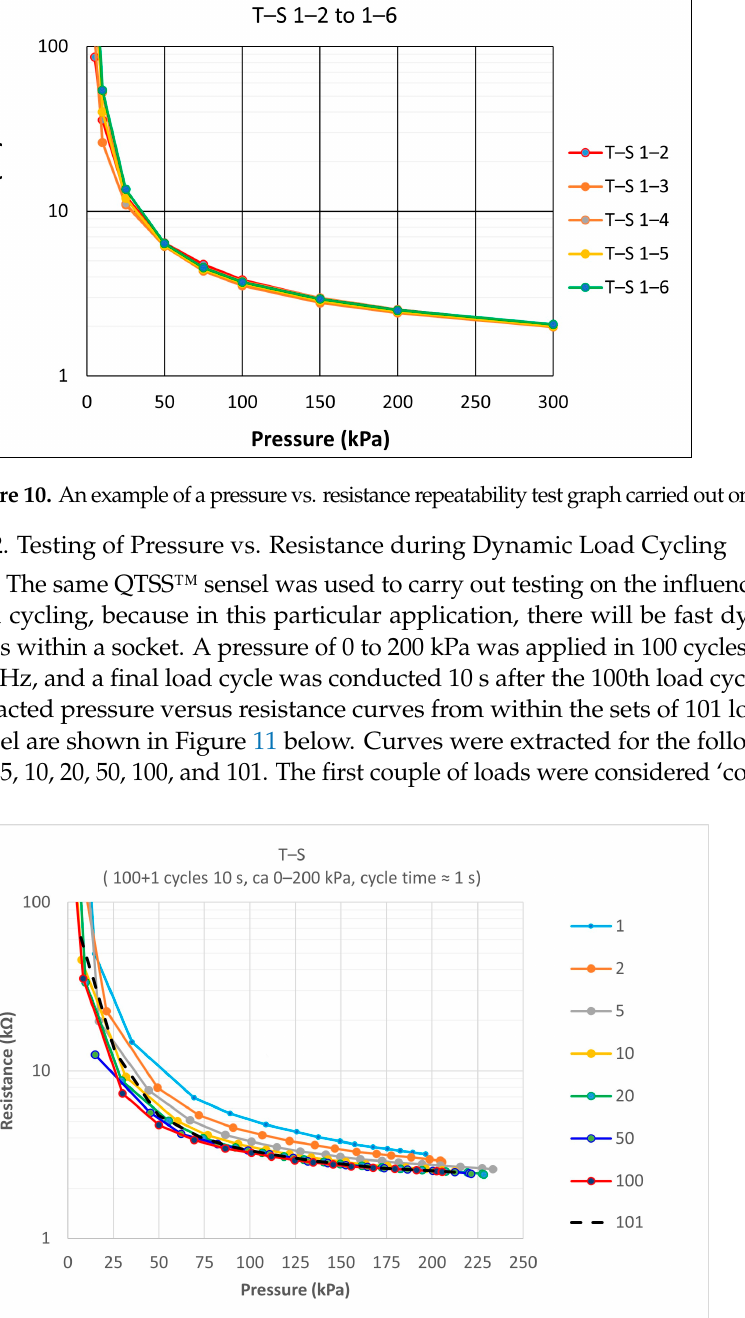
Figure 10. An example of a pressure vs. resistance repeatability test graph carried out on one QTSS™ sensel.